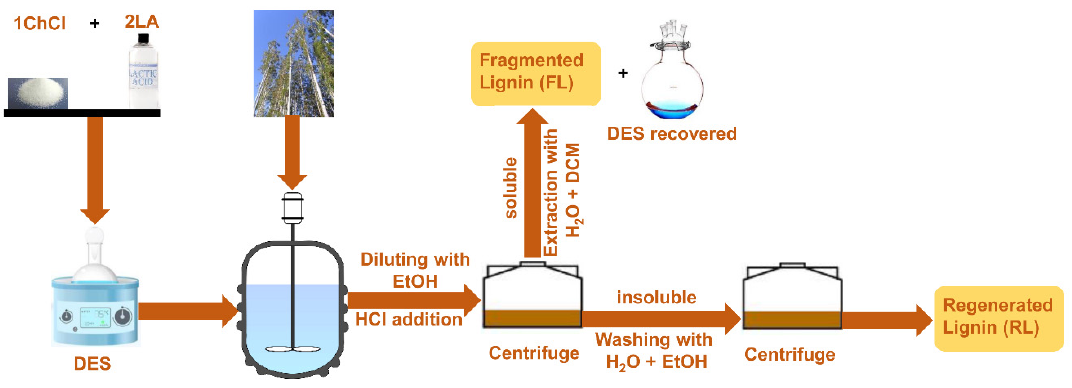
Figure 14. The flowchart for lignin treatment with DES.